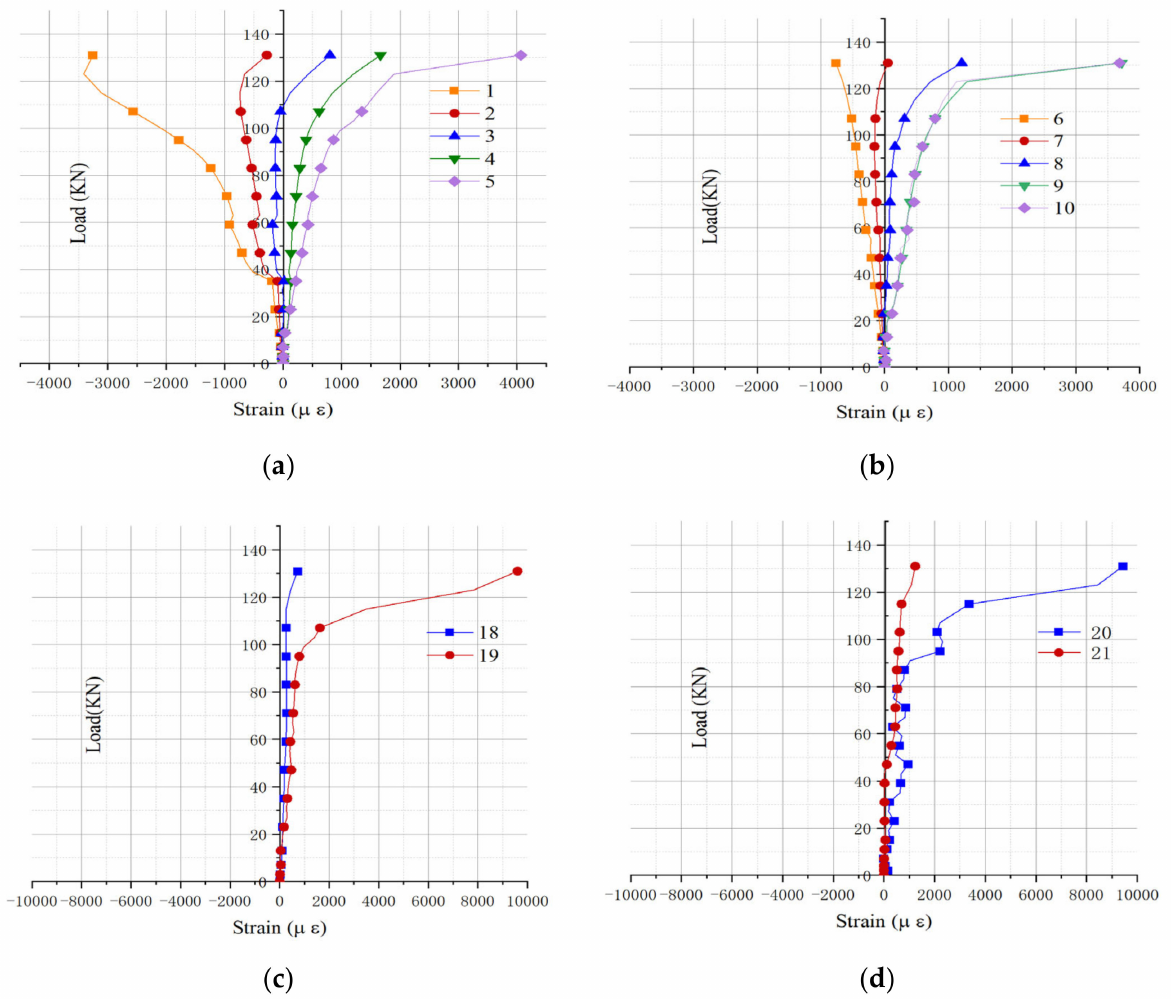
Figure 9. Load-strain curve of different measuring points of L2: ( a ) 1–5 strain gauge; ( b ) 6–10 strain gauge; ( c ) 18–19 strain gauge; ( d ) 20–21 strain